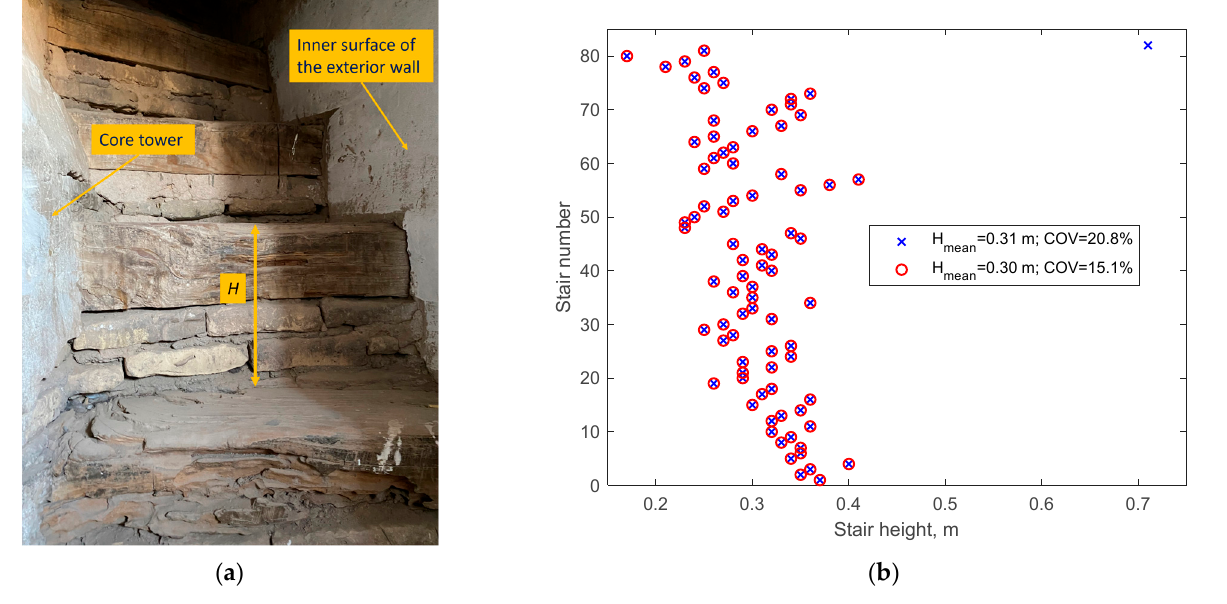
Figure 10. Height measurements of each stair: ( a ) schematic of measuring procedure; ( b ) heights of all stairs.